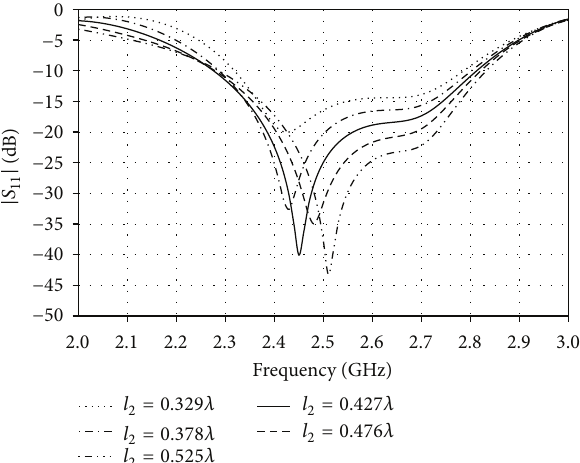
Figure 9: Simulated |𝑆 11 | for various electric probe heights ( 𝑙 ).